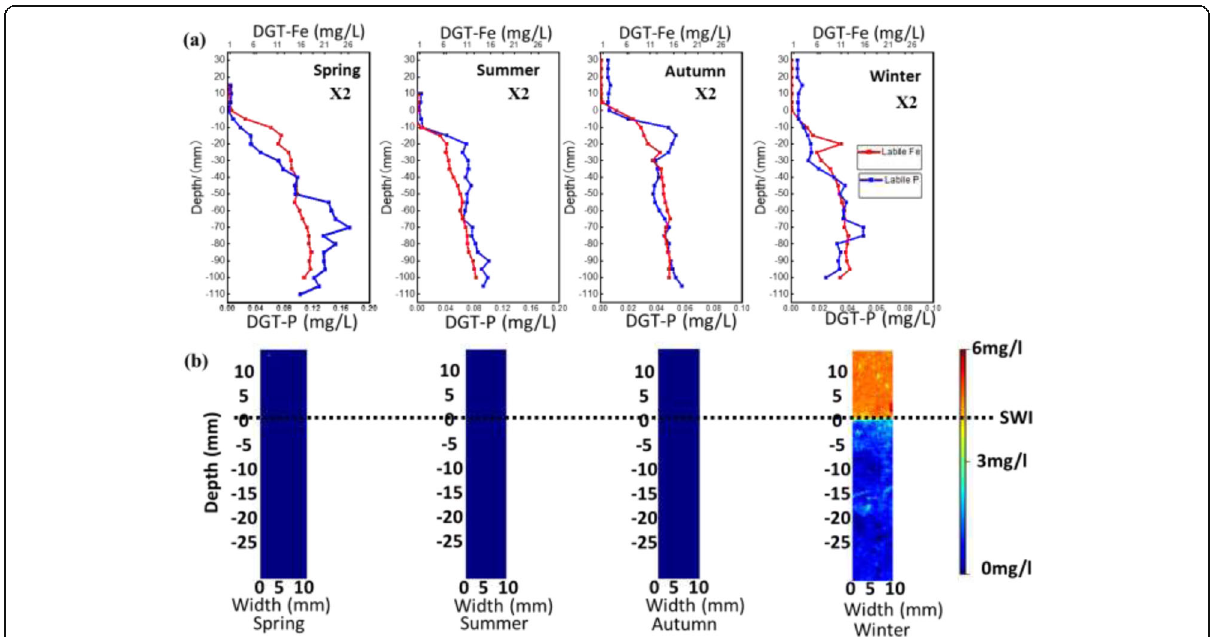
Fig. 4 Seasonal variations at sampling site X1. a The DGT-labile P and labile Fe concentrations with depth at the sediment-water interface (SWI) and b oxygen concentration at the SWI (2D imaging) of Tianbao Reservoir. The position of the SWI is represented by